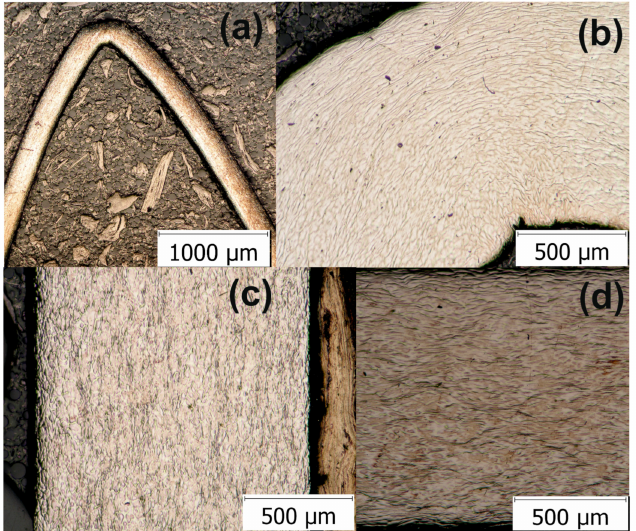
Figure 3. Optical microscopy image of the GUM metal: ( a ) orthopedic staple, ( b ) bending area of the staple, ( c ) HSHPT + CR processed clamp in the longitudinal rolling direction and ( d ) in the transverse rolling